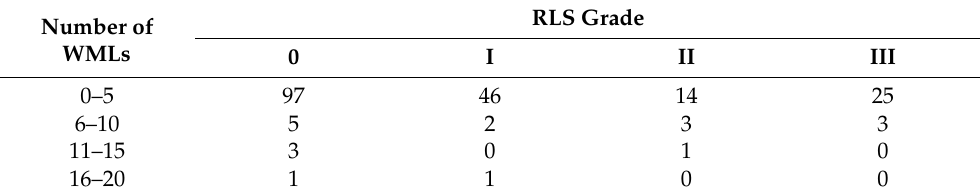
Table 3. Correlation between the number of white matter lesions and RLS grade.